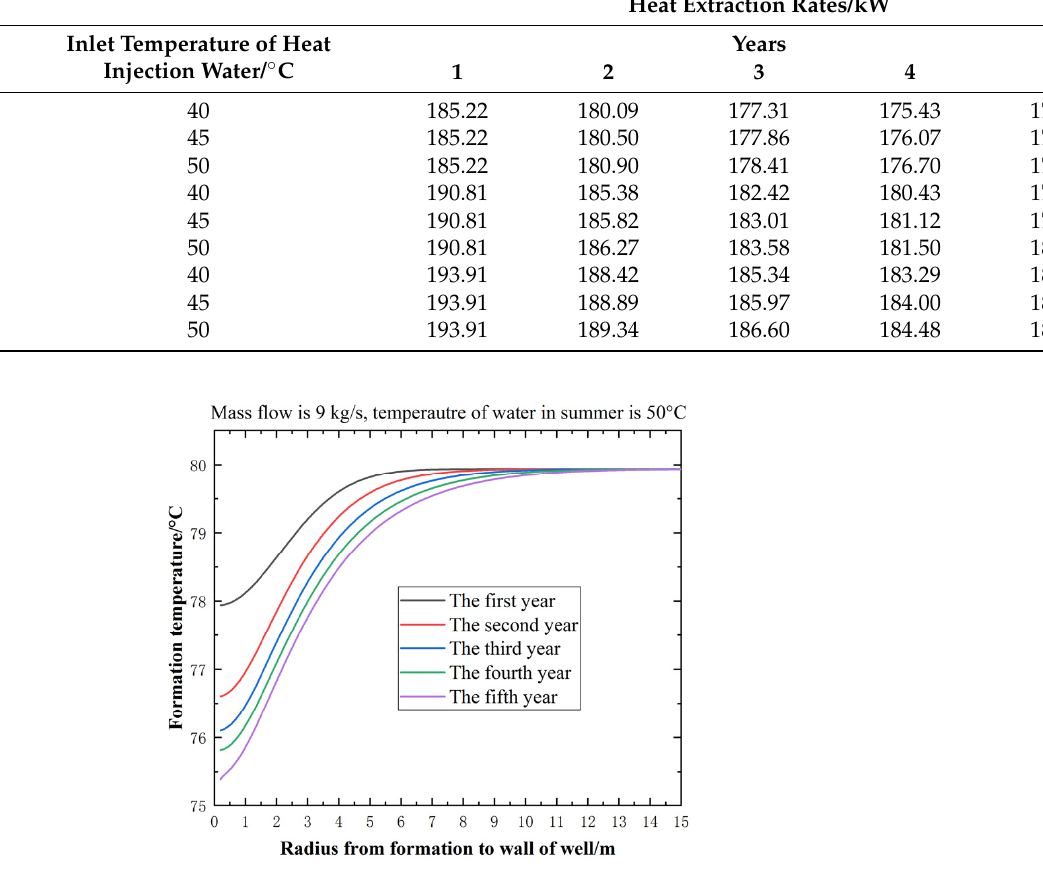
Figure 11. Formation temperature at the depth of 1998 m over five years.